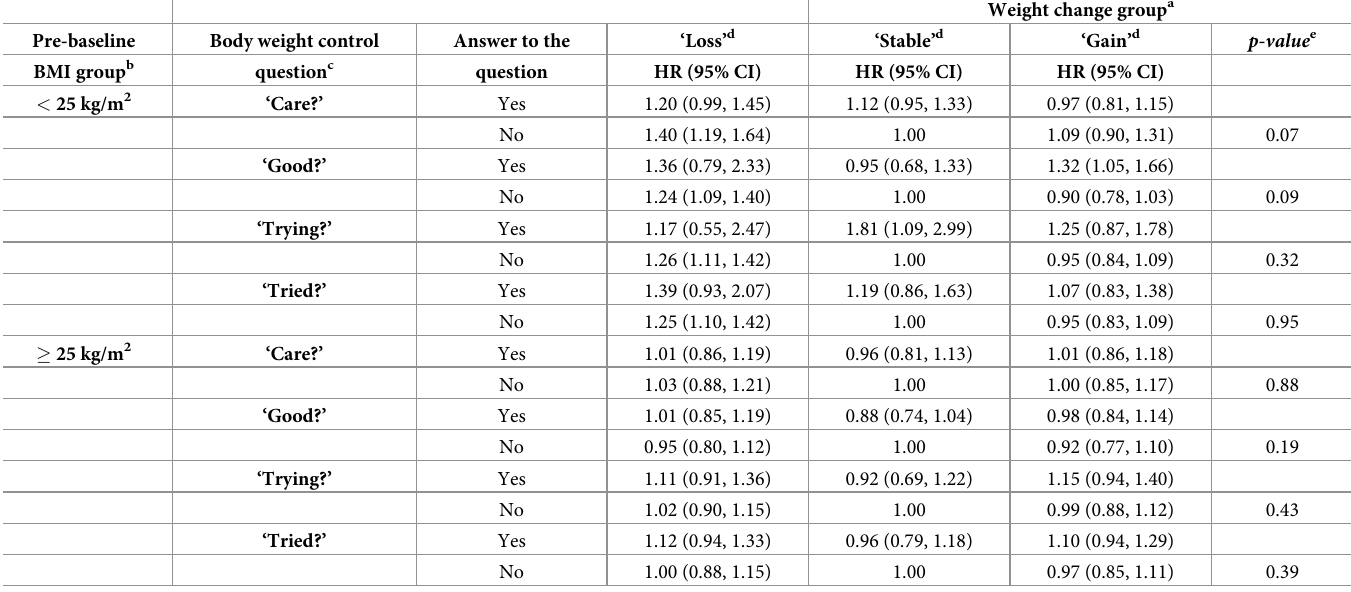
Table 2. All-cause mortality according to body weight changes combined with body weight control